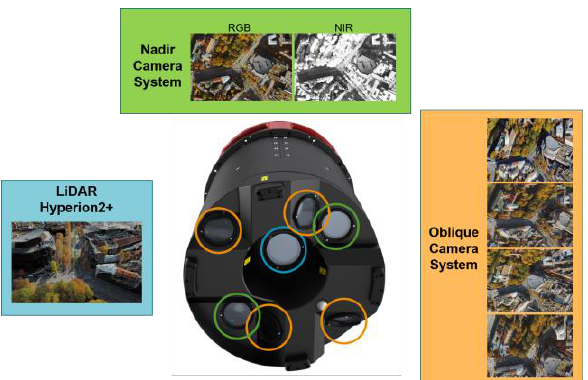
Figure 1: Leica CityMapper-2 hybrid sensor with 1 st class sub- systems